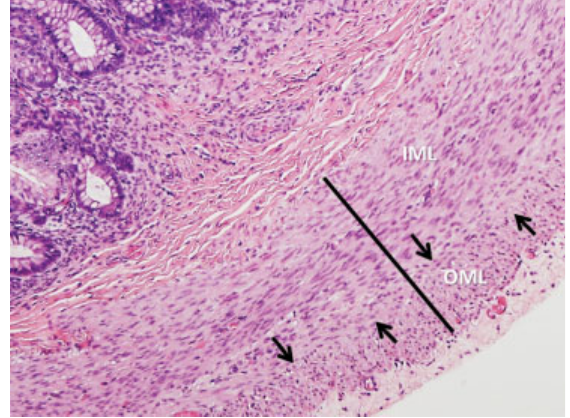
Fig. 5 H&E stain ( (cid:1) 100). Appendix of a 3-day-old infant with total colonic Hirschsprung disease (HD). No ganglion cells in the appendix. The normal location of the myenteric plexus is designated by arrows. The muscularis propria is indicated by the solid line. IML, inner muscular layer; OML, outer muscular